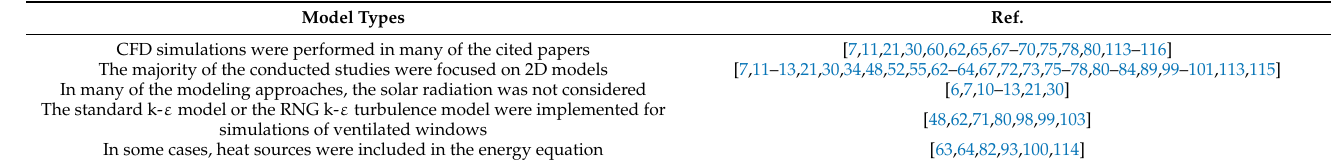
Table 3. Summary of the presented different approaches to mathematical modeling of the thermal transmission through windows.